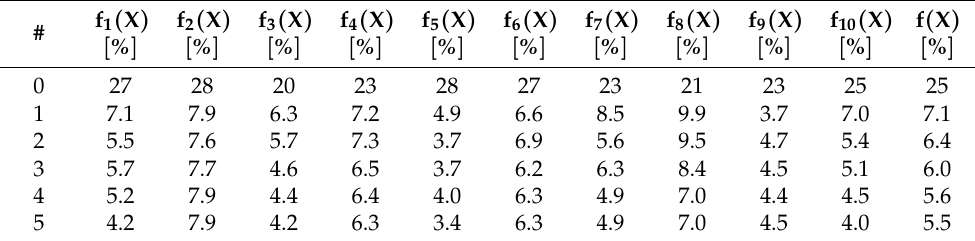
Table 4. The objective function values during